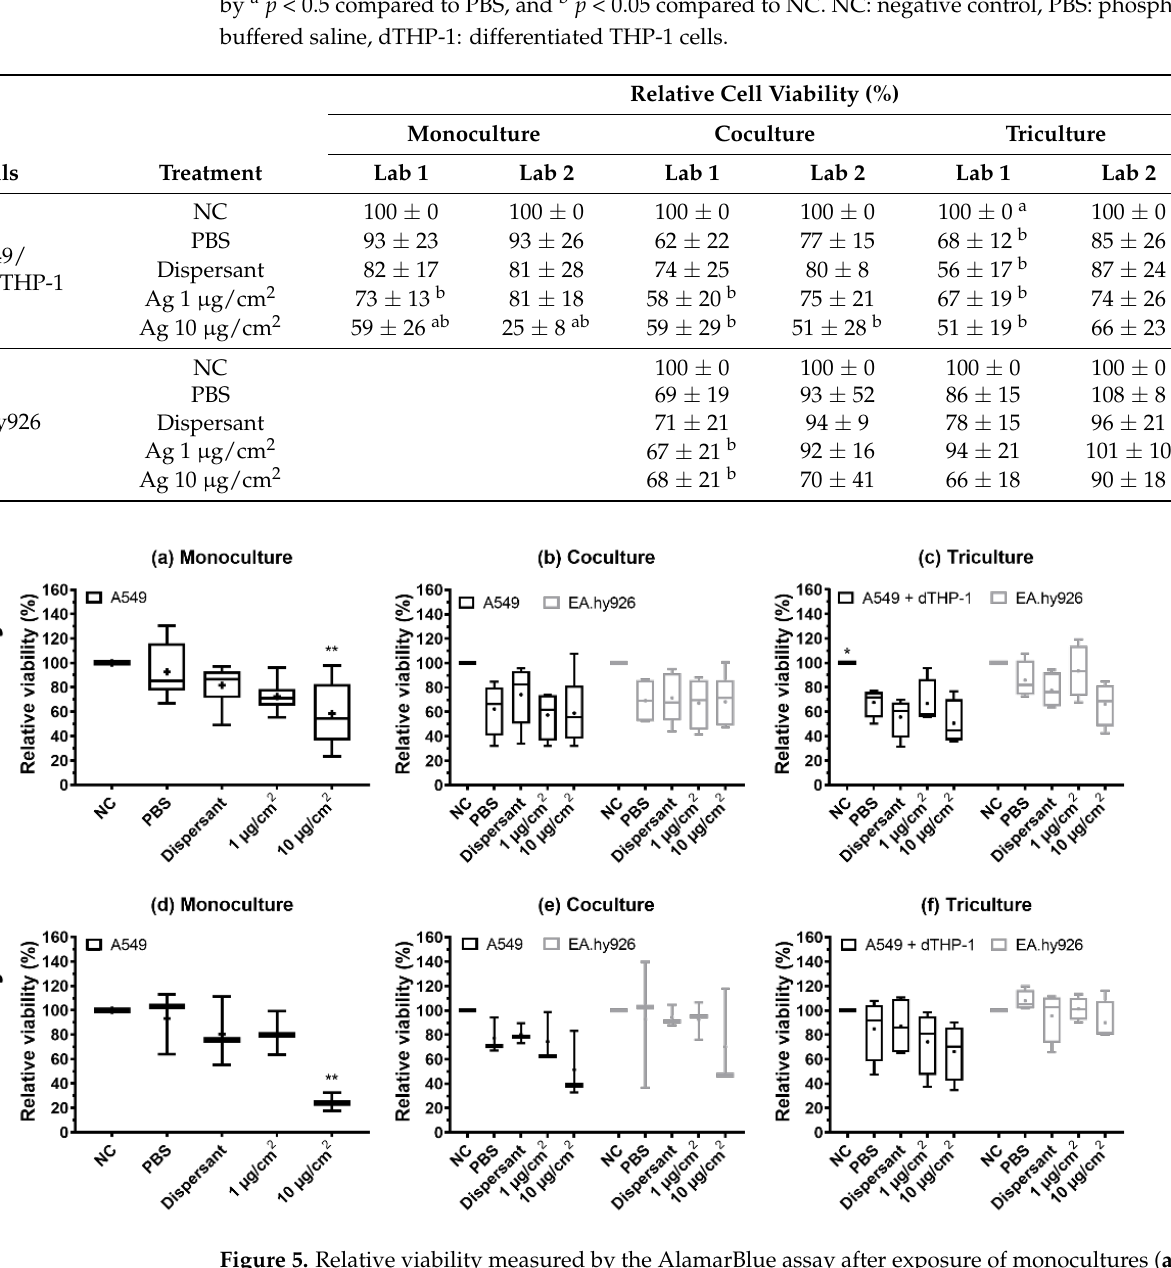
Figure 5. Relative viability measured by the AlamarBlue assay after exposure of monocultures ( a , d ), cocultures ( b , e ), and tricultures ( c , f ) of A549, EA.hy926, and dTHP-1 cells to NM-300K and control solutions at the air–liquid interface (ALI). Experiments were performed at Lab 1 ( a – c ) and Lab 2 ( d – f ) for comparison. A reduction in viability was seen after exposure to control solutions and NM- 300K at ALI. Results are normalized against negative incubator control (NC, set to 100%) and pre- sented as boxplots with mean (+), median/50th percentile (line), 25th and 75th percentiles (box), and minimum and maximum values (whiskers). A total of ( a ) n = 6 – 9, ( b ) n = 4 – 5, ( c ) n = 4, ( d , e ) n = 3, and ( f ) n = 4 independent experiments with each 1 – 2 replica cell culture inserts were performed. Statistically significant differences compared to PBS control were analyzed by ordinary one-way